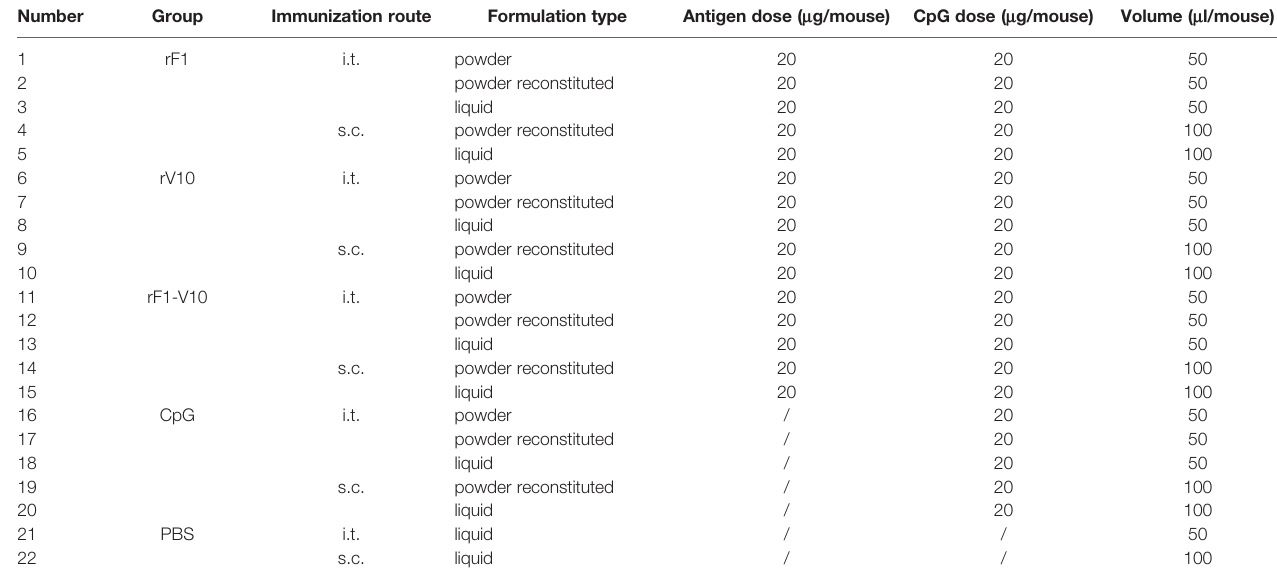
TABLE 1 | Summary of immunization groups used in the experiment.